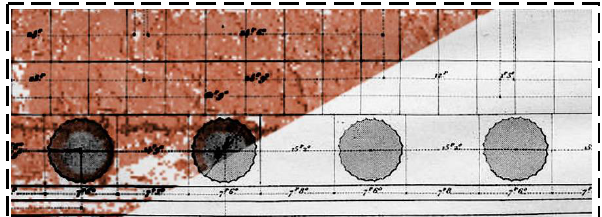
Figure 7: Detail view for Figure 6 of the laser model (in brown) overlapped onto the historical